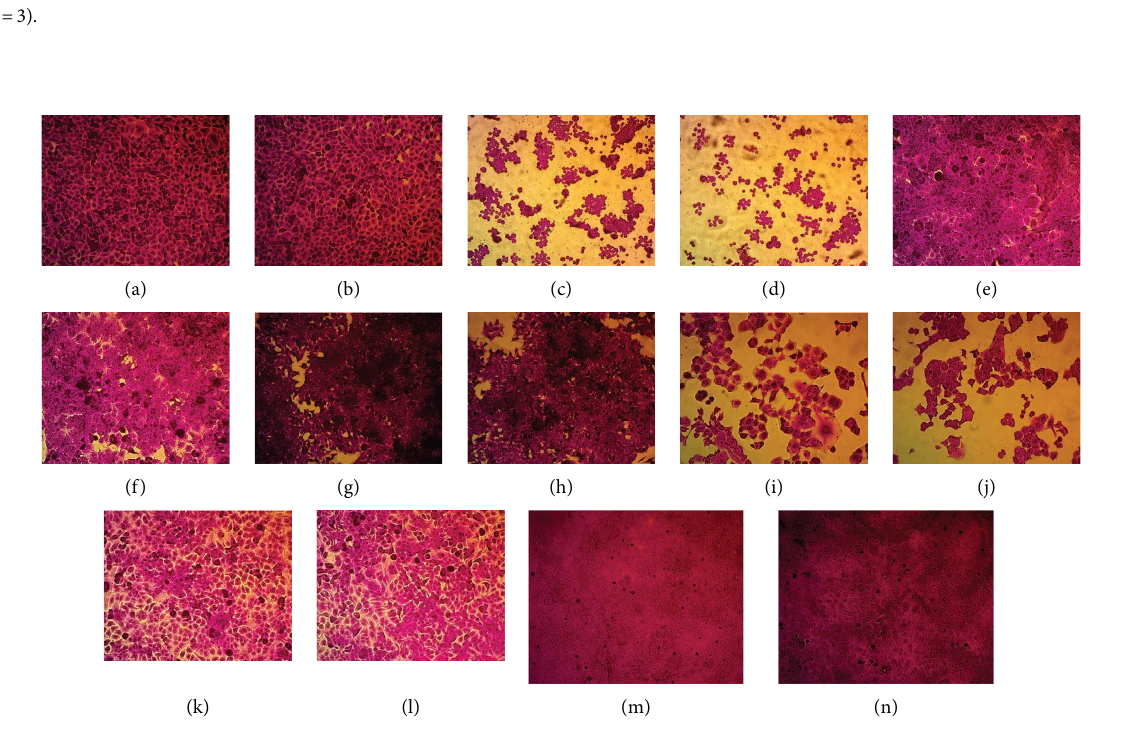
Figure 2: Te optical microscope stained images of cytotoxicity assays of the seven cell lines: (a) A-549 (10 µ g/mL), (b) A-549 (100 µ g/mL), (c) colo-205 (10 µ g/mL), (d) colo-205 (100 µ g/mL), (e) huh-7 (10 µ g/mL), (f) huh-7 (100 µ g/mL), (g) HCT-116 (10 µ g/mL), (h) HCT-116 (100 µ g/mL), (i) PANC-1 (10 µ g/mL), (j) PANC-1 (100 µ g/mL), (k) SKOV-3 (10 µ g/mL), (l) SKOV-3 (100 µ g/mL), (m) BNL (10 µ g/mL), and (n) BNL (100 µ g/mL), magnifcation power: 200 ×